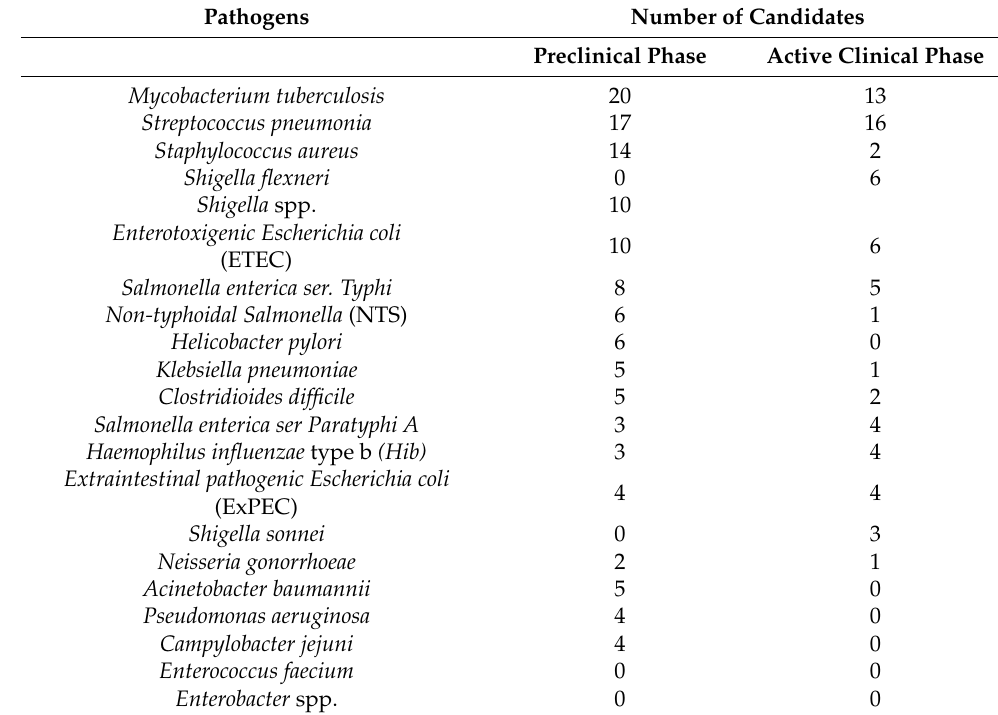
Table 2. Number of vaccine candidates by pathogen in preclinical and active clinical